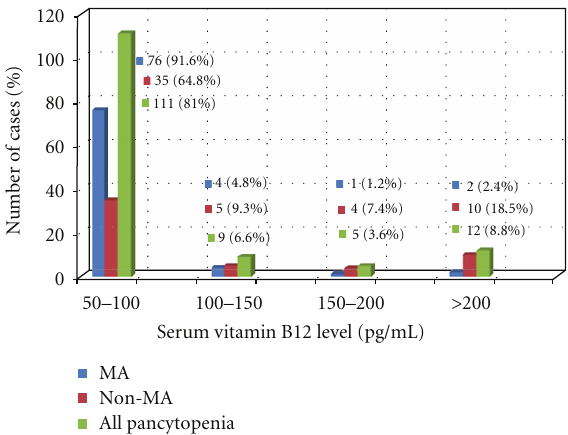
Figure 3: Severity of Vitamin B12 deficiency in pancytopenia.